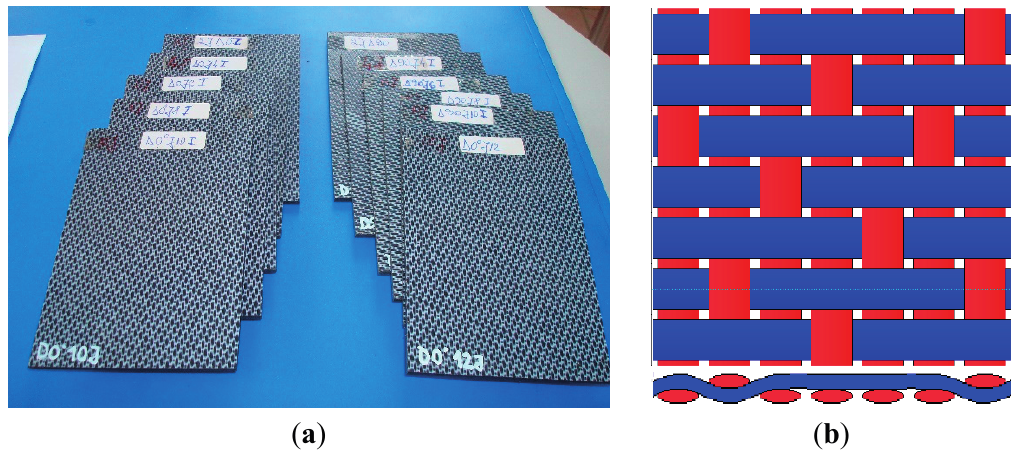
Figure 6. Studied samples: ( a ) Photo; ( b ) 5HS woven